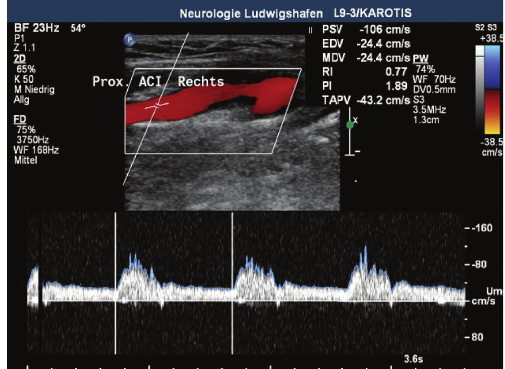
Figure 3: Considerably reduced PSV in the right ICA (automatic detection shows a normal PSV due to the measurement of poststenotic